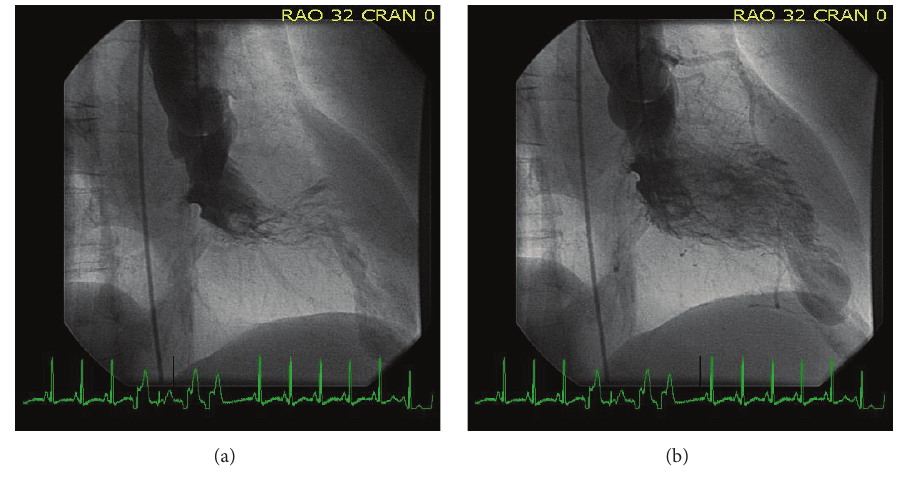
Figure 2: Left ventriculogram demonstrating midventricular obstruction with large aneurysmal apical pouch (diastole and